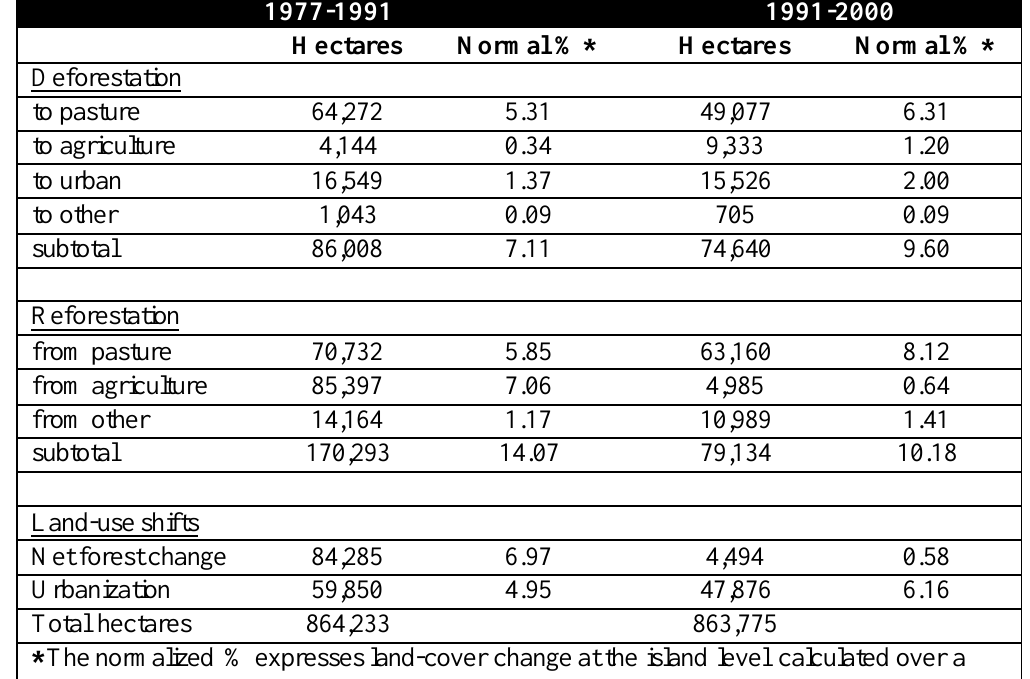
Table A3: Key land-cover transitions in Puerto Rico, 1977-2000. Land-cover change calculated from the GIS land-cover maps described above. Deforestation measures transitions from forest to non-forest land- covers, and is broken down by non-forest category. Similarly, reforestation marks transitions from non- forest to forest land-covers, broken down by non-forest category. The “other” category includes all other non-forest categories (listed in Table A2). Net forest change subtracts deforestation from reforestation, and urbanization measures transitions from all land-covers to urban cover. Total hectares for the island of Puerto Rico were similar between land-cover transition maps, with minor changes (0.05% of total area) due to classification error with water (excluded here). See Kennaway and Helmer (2007) for detailed land transition